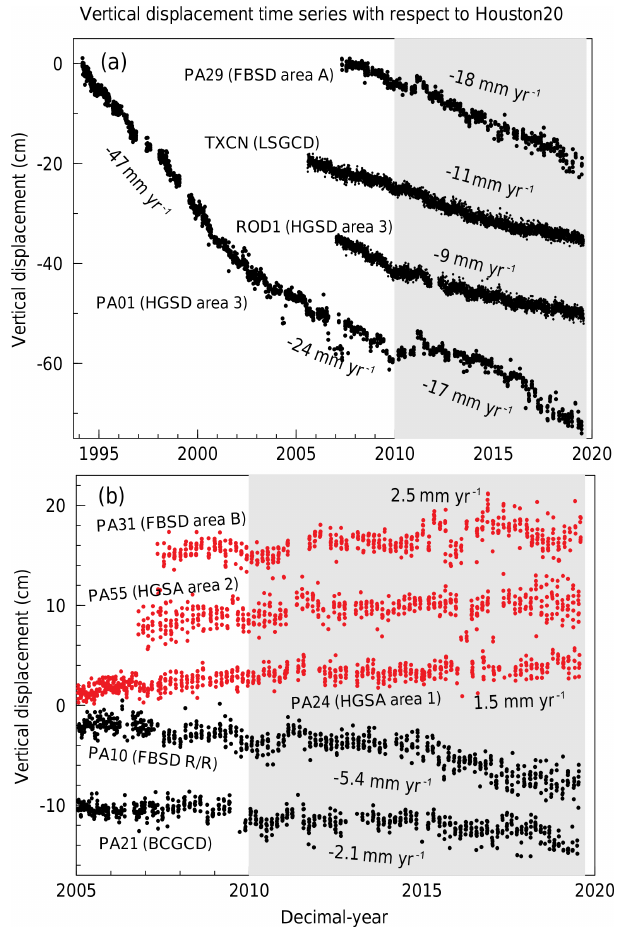
Figure 3. Subsidence (black) and uplift (red) time series at typical GPS sites located in different groundwater regulation zones within the Greater Houston